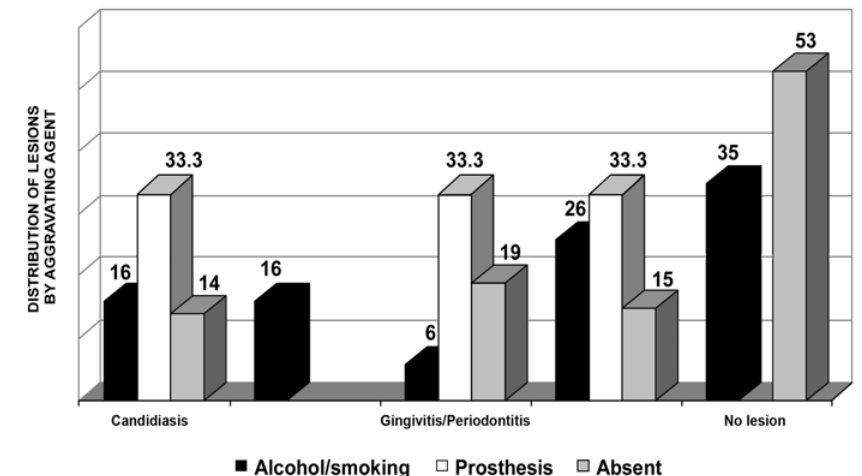
FIGURE 4- Distribution (%) of oral lesions according to the aggravating agent